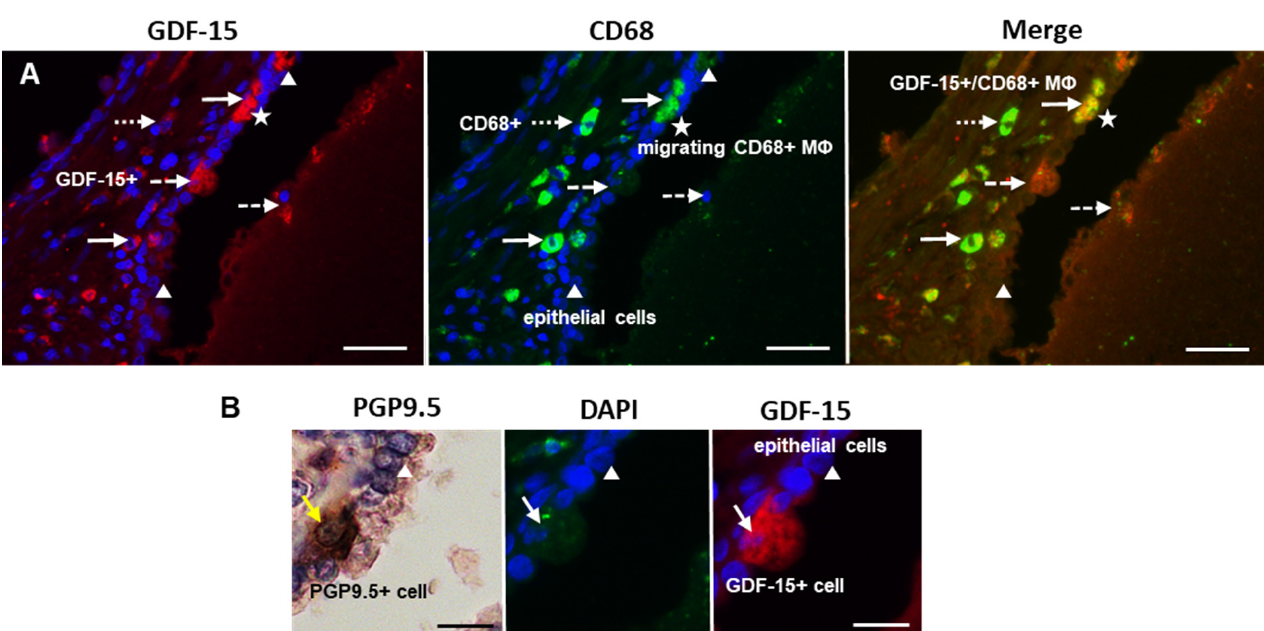
Figure 5. ( A ) Double-immunofluorescence of GDF-15 (Cy3, red) and CD68 (Alexa Fluor ® 488, green) in PCa. White arrows indicate the double-positive (GDF-15+/CD68+ M Φ ); white arrows with a dotted line indicate single-CD68+ M Φ ; and arrows with a dashed line mark single-GDF-15+; white stars indicate transepithelial migrating CD68+ M Φ ; white triangles mark epithelial lining cells of the prostate glands; scale bar 100 µm. ( B ) Photos of serial cross sections showing neuroendocrine PGP9.5+ and GDF-15+ cells; PGP9.5+ cells are marked with yellow arrows and GDF-15+ cells with white arrows; white triangles mark epithelial lining cells; nuclei were counterstained with DAPI (blue); scale bar 25 µm.